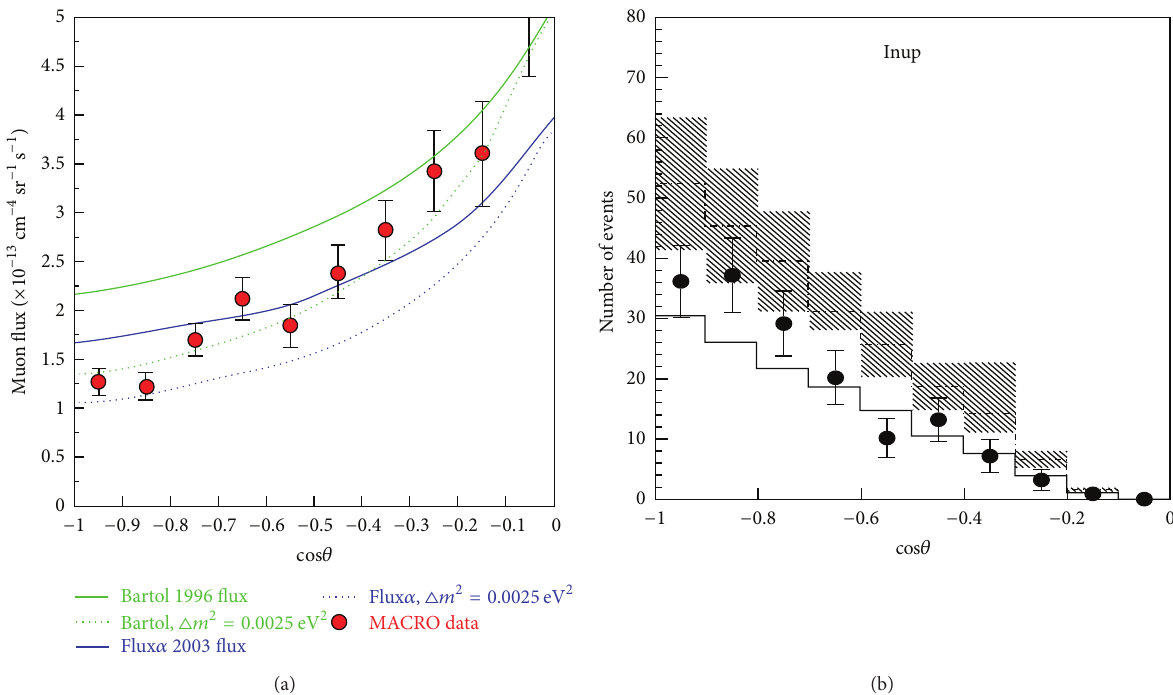
Figure 5: (a) MACRO up-through-going muons compared with oscillated and nonoscillated predictions of different MCs [68]. (b) Measured zenith distributions for the IU low energy events. The black points are data; the shaded region is the MC predictions with no oscillations. The full line is for ] 𝜇 ↔ ] 𝜏 oscillations with maximal mixing and Δ𝑚 2 = 2.3 × 10 −3 eV 2 .